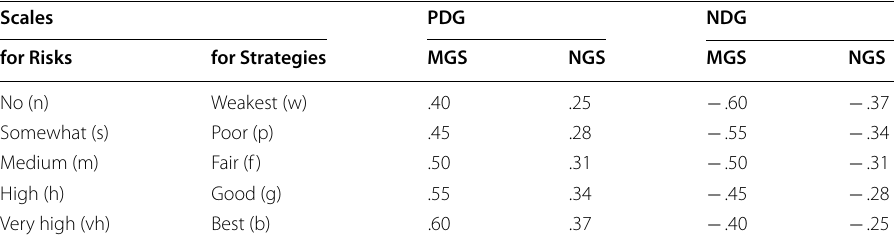
Table 2 Scale and degrees Scales